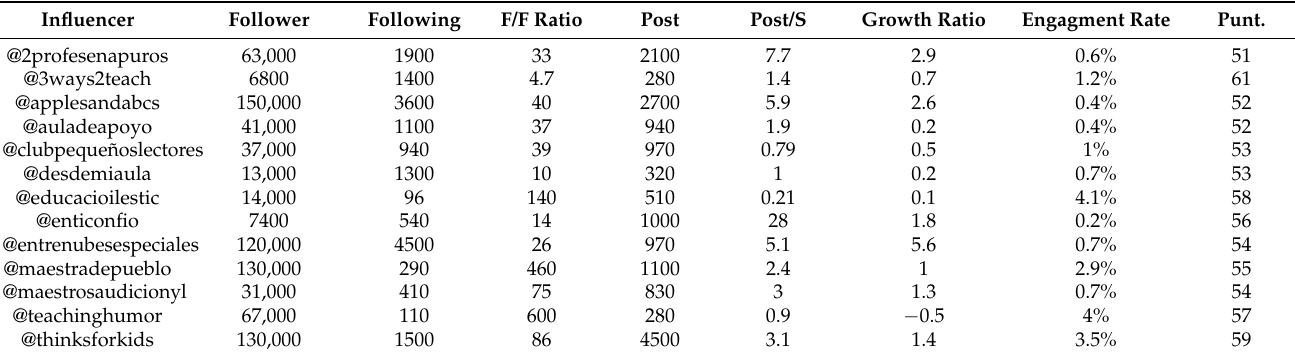
Table 4. Interaction of educational influencers.